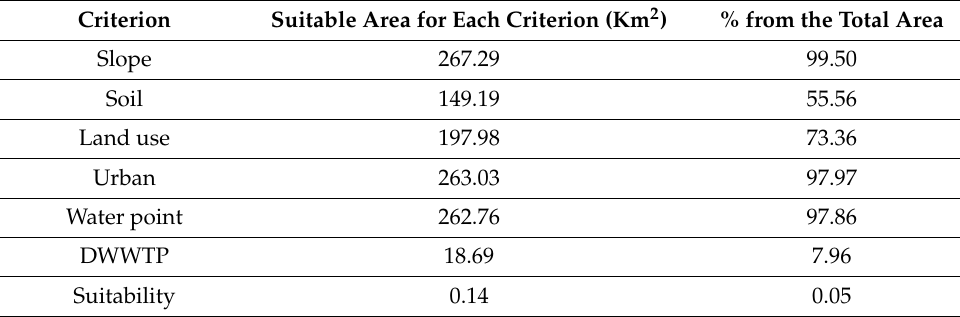
Figure 6. Suitability map for the GWRC basins in the study area. Table 3. Selected suitable area for GWRC basins based on each